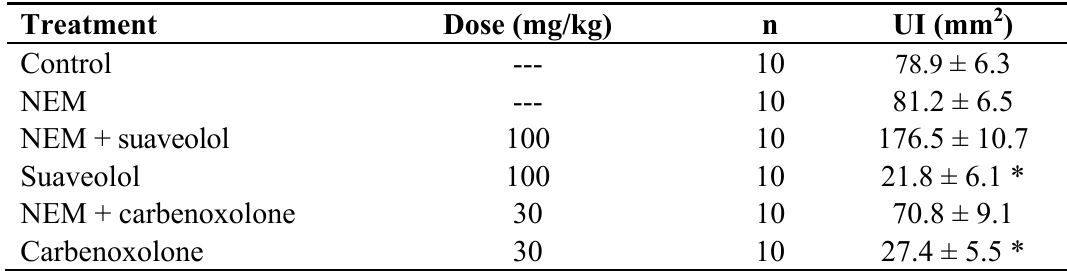
Table 5. Effect of suaveolol and carbenoxolone on gastric lesions induced by ethanol in rats pretreated with NEM (10